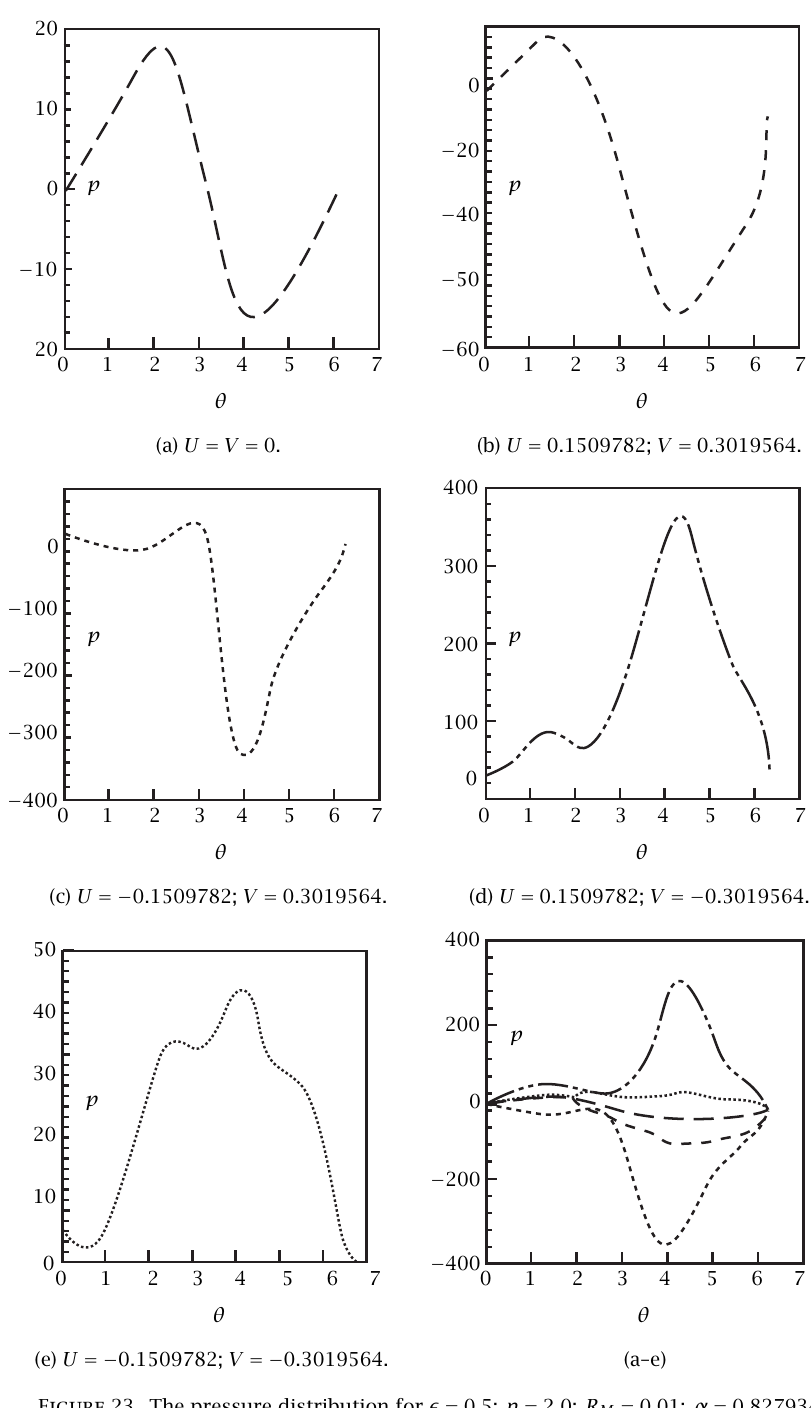
Figure 23 . The pressure distribution for (cid:9) = 0 . 5; η = 2 . 0; R M = 0 . 01; α = 0 .